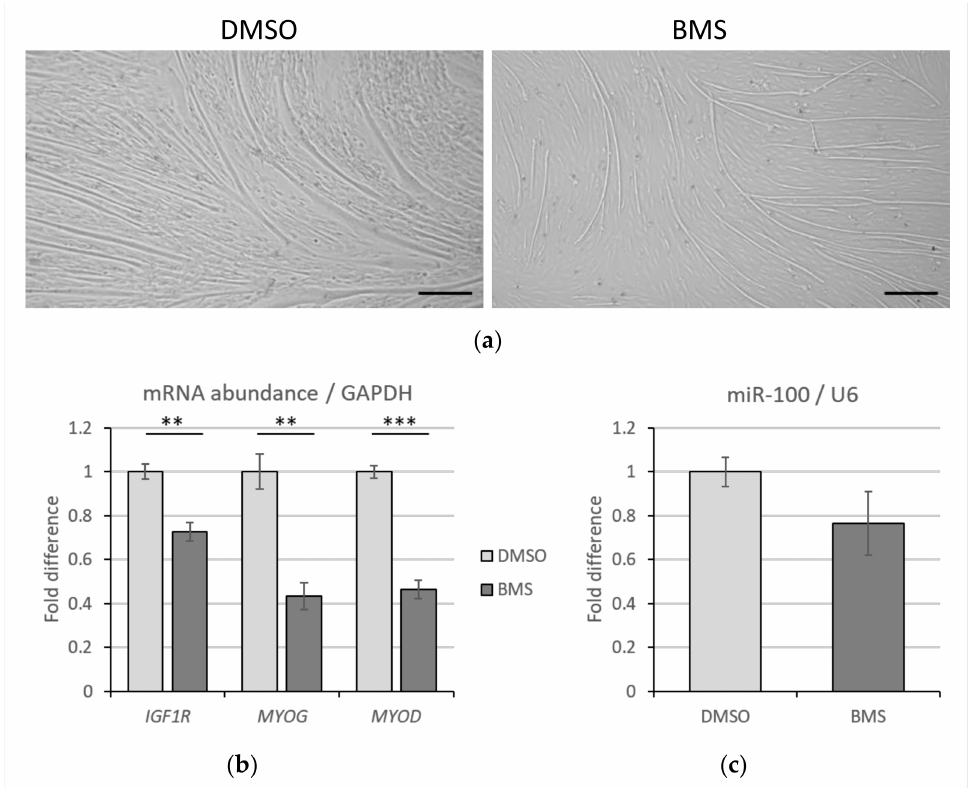
Figure 4. Impact of molecular inhibition of IGF1R on miR-100 levels and myogenic differentiation. ( a ) Morphology of myotubes treated with IGF1R inhibitor, BMS-754807 (BMS). Scale bar represents 200 µ m. ( b ) Impact of BMS on IGF1R , MYOG, and MYOD transcript levels and ( c ) miR-100 expression in BMSC myotubes. Data is representative of three independent experimental replicates per sample group. Expression levels are presented as fold differences. Significant differences to DMSO are indicated with ** if p < 0.01 and with *** if p <